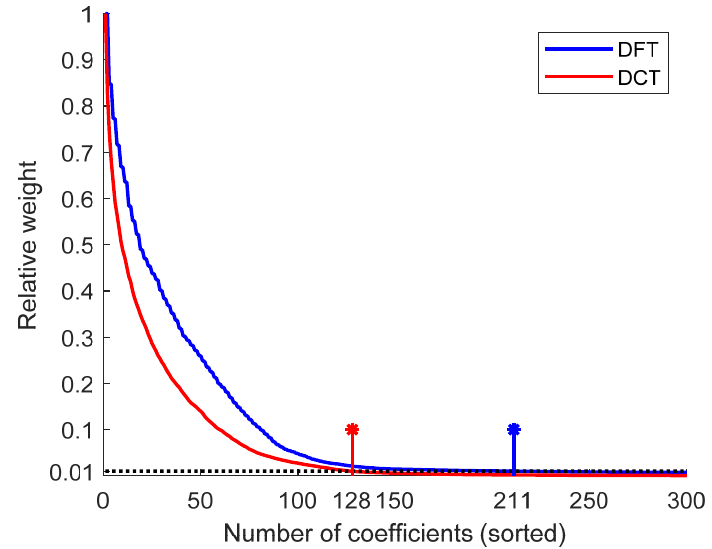
Figure 4. Comparison of K-sparsity of an original signal processed using the discrete Fourier transform (DFT) and discrete cosine transform (DCT) basis matrices.